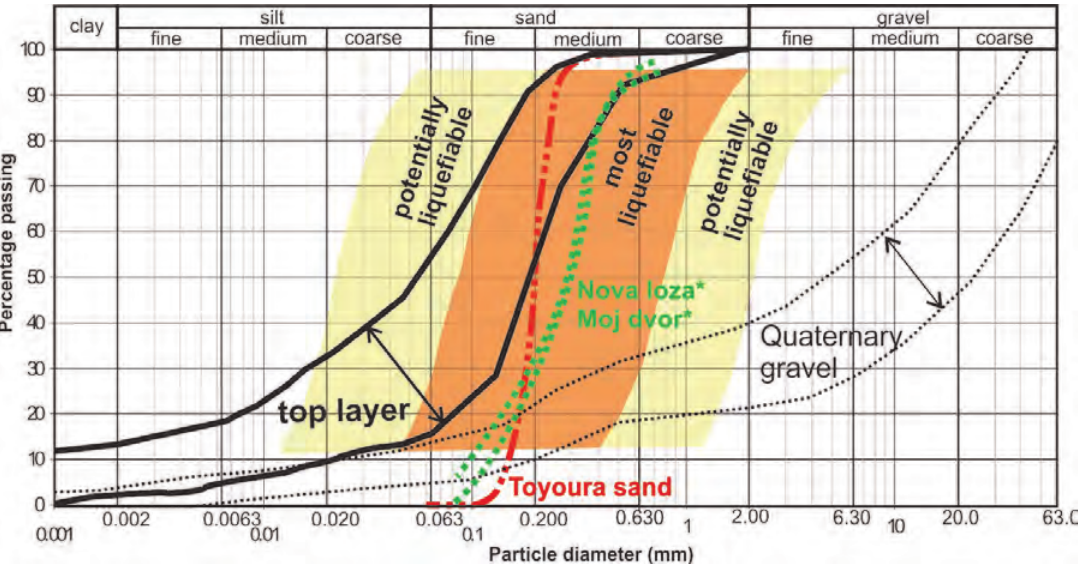
Figure 3. Relationship between grading and liquefaction potential [13], with the boundaries of the grading of top layer and quaternary gravel at the HPP Brežice. Grading curves *Nova Loza and *Moj dvor, reported by Veinović et al. [7] belong to the area, where liquefaction appeared in 1880.